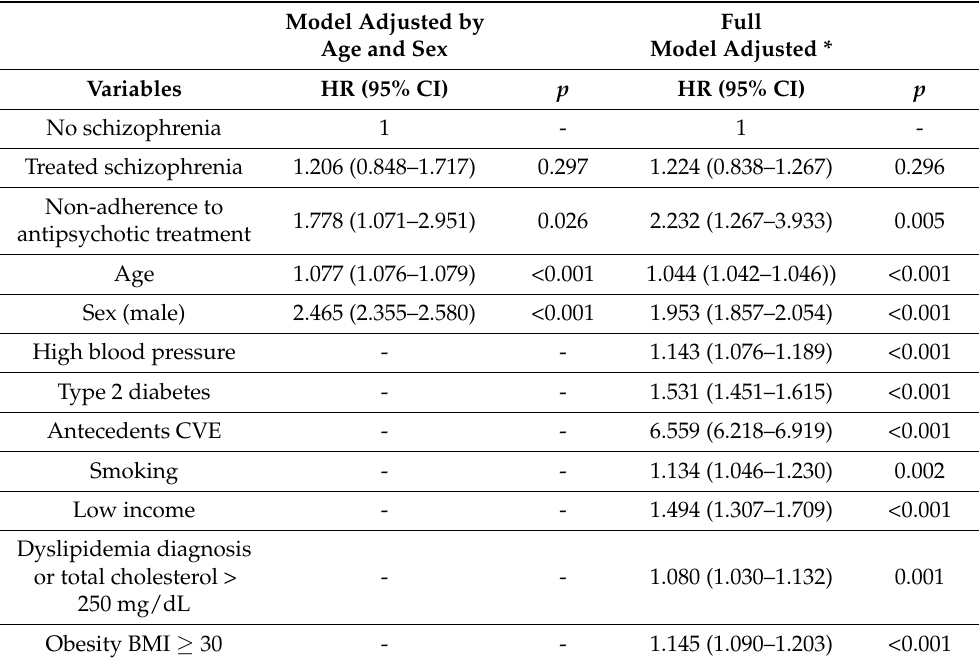
Table 4. Cox regression for hospital admission for cardiovascular events according to schizophrenia